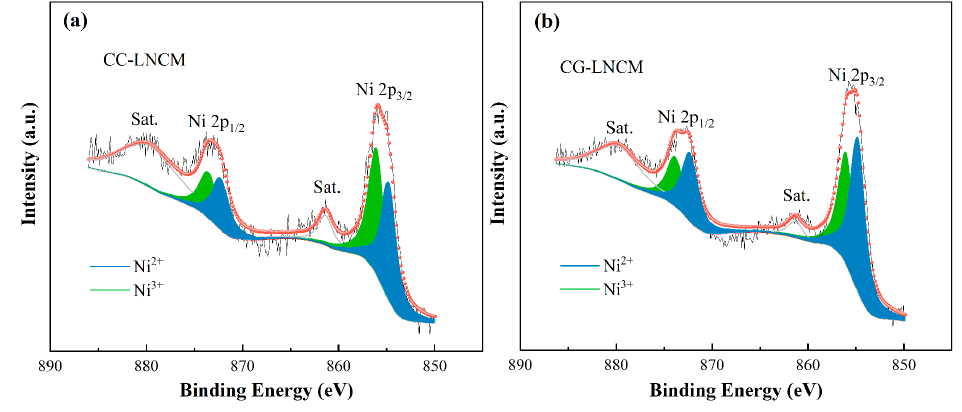
Figure 4. Ni 2p XPS spectra of ( a ) CC-LNCM and ( b )